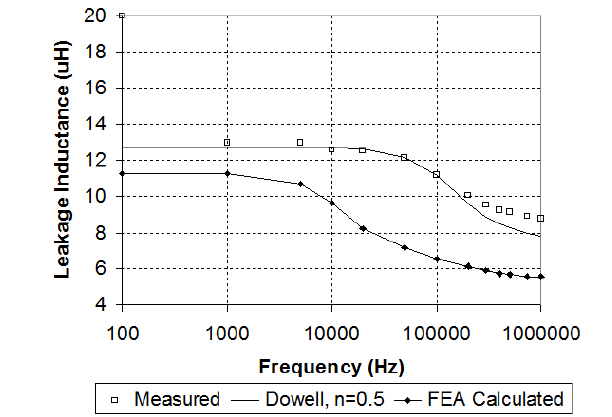
Figure 3: Simple 2D Transformer Model